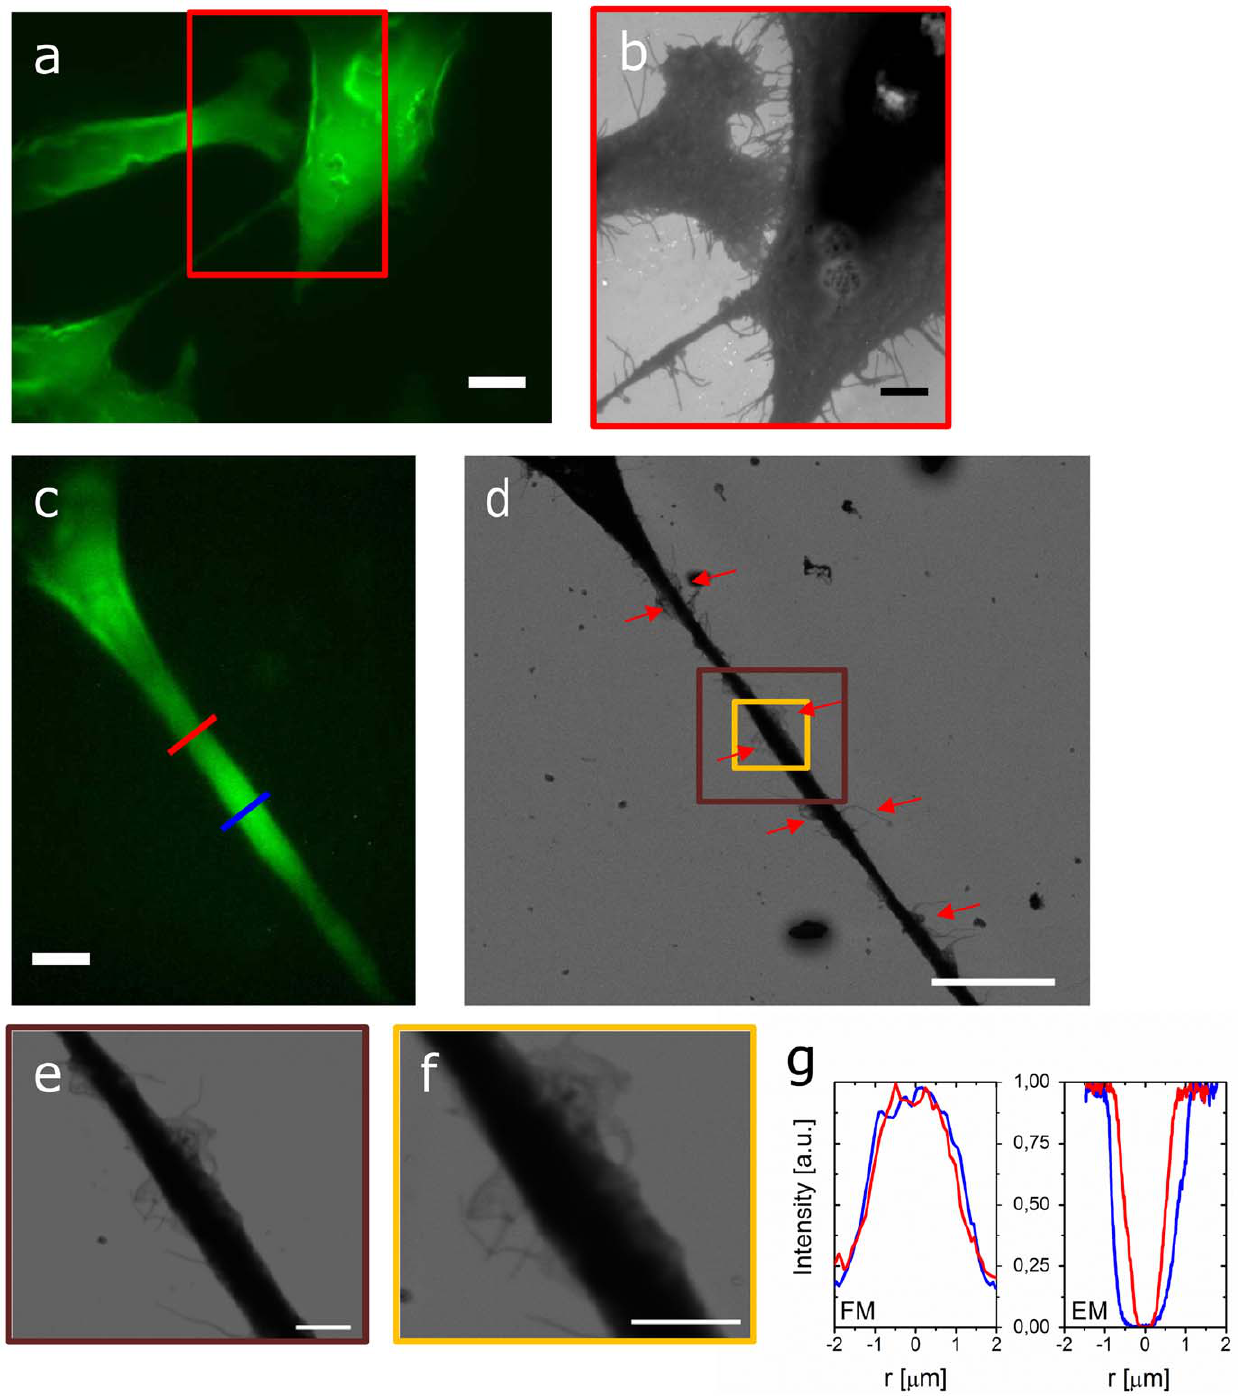
Figure 2. SCLEM of whole uncoated cells. (a) FM image of three adenocarcinoma cells actin labeled with Alexa488. The three cells are connected via tentacles and larger extrusions. Scalebar 5 m m. (b) SEM image of the boxed area in (a), showing detailed information on the connections between the cells. A dense network of tentacles and lamellae stretches between the upper and the right cell. Scalebar 3 m m(c) FM image of an extension connecting another two adenocarcinoma cells. Clear variations in actin concentration along the extrusion can be observed. (b) BSE image of the extrusion in (a). Red arrows mark areas with increased concentration of tentacles that occur before and after the thinner parts of the extrusion. Scale bar is 10 m m. (d, e) SE and BSE high-magnification images of the boxed areas in (b) showing a region rich in tentacles and small lamellar extrusions. Scale bars are 2 m m. (f) Fluorescence intensity profiles, normalized on the maximum, taken along the red and blue lines in (a). (g) Normalized SE intensity profile taken at the corresponding locations marked in